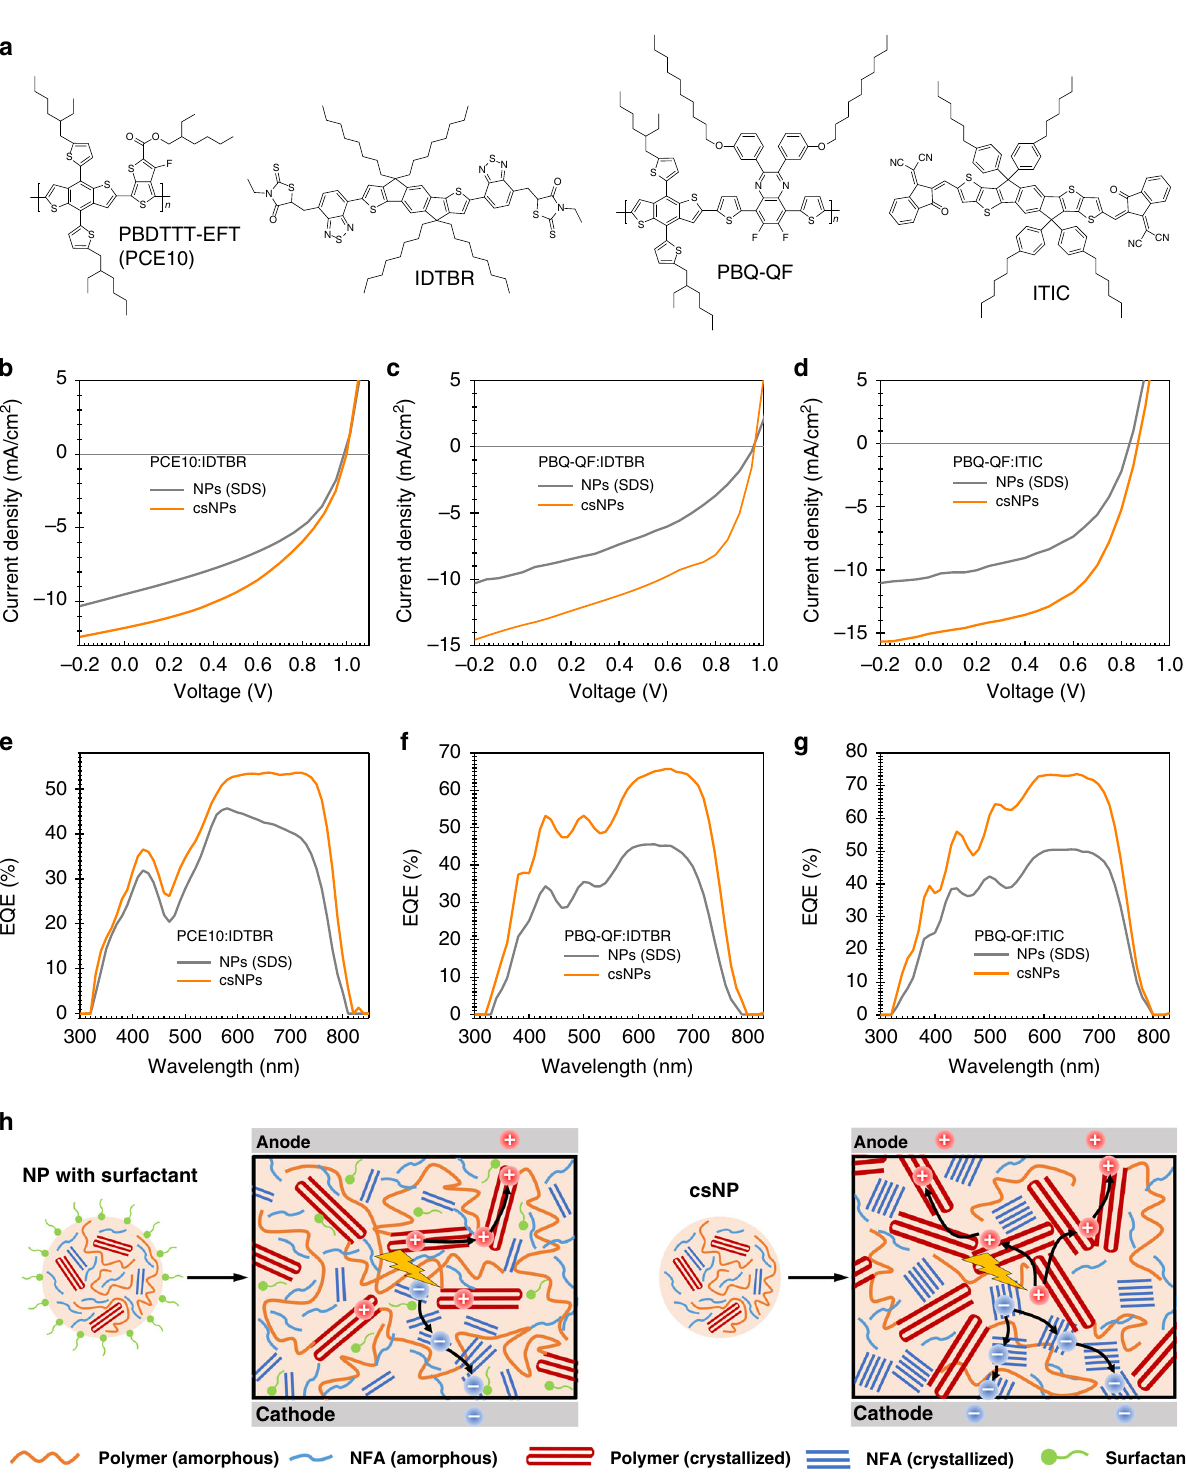
Polymer (amorphous) Polymer (crystallized) Fig. 5 Generality of surfactant-stripping technique for polymer:NFA solar cells. a Chemical structure of donors and acceptors for generality test of surfactant-stripping technique. b , c , d Light current – voltage characteristics and e , f , g EQE of b , e PCE10:IDTBR, c , f PBQ-QF:IDTBR and d , g PBQ-QF:ITIC- based solar cells processed by water dispersion with NPs (SDS) and cs-NPs; h Schematic diagram of NP (SDS) and cs-NP structures as well as morphology and charge transport in their corresponding NP con fi dent that this generic concept of cs-NP is potentially viable transferred to the large-scale fabrication through the combination for processing other water-based organic photoelectronics with of mass synthesis, cross- fl ow ultra fi ltration 63 and roll-to-roll printing. In addition, by means of low-cost P3HT:NFA system 64 high performances, such as organic fi eld effect transistors (OFETs), organic light-emitting diode (OLED) and organic with cs-NP processing, it is expected to achieve commercially photodetectors. viable OPVs with the cost around 10 € g − 165 . Further, we are